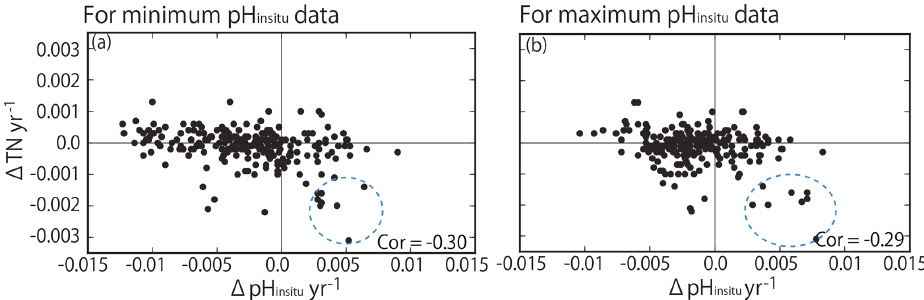
Figure 14. Correlation between trends in total nitrogen (TN) and trends in (a) minimum and (b) maximum pH insitu . The correlation co- efficients are − 0.30 and − 0.29 for the minimum and maximum pH insitu , respectively (significance level of 0.05, r = 0.128; degrees of freedom = 236). Dotted blue circles indicate the data measured in Shimotsu Bay in Wakayama